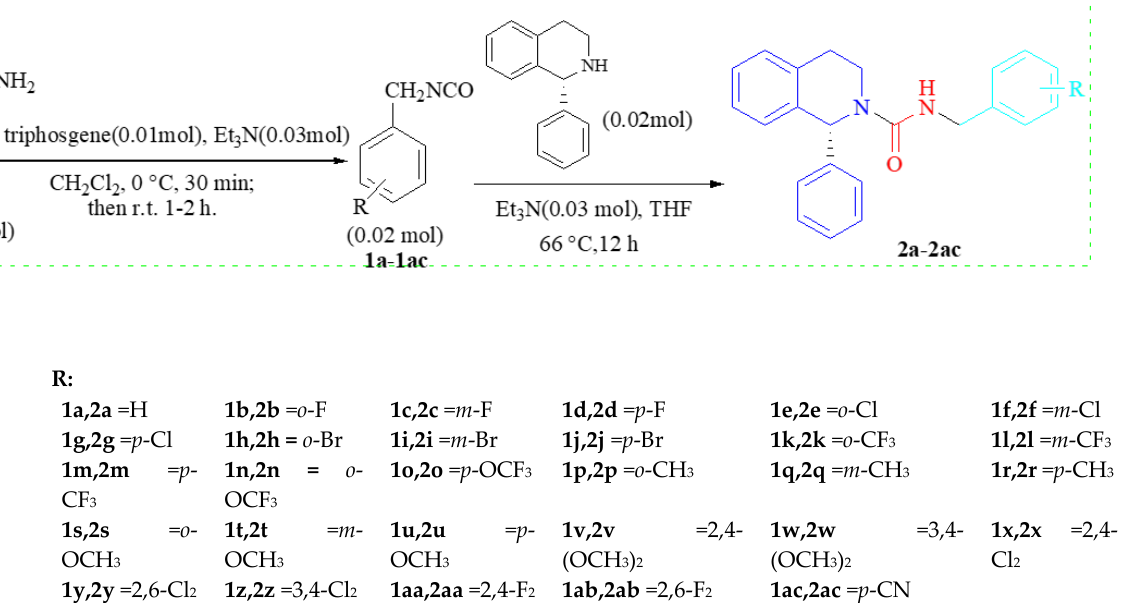
Figure 3. Upfield shifting and splitting of signal in compound 2v .